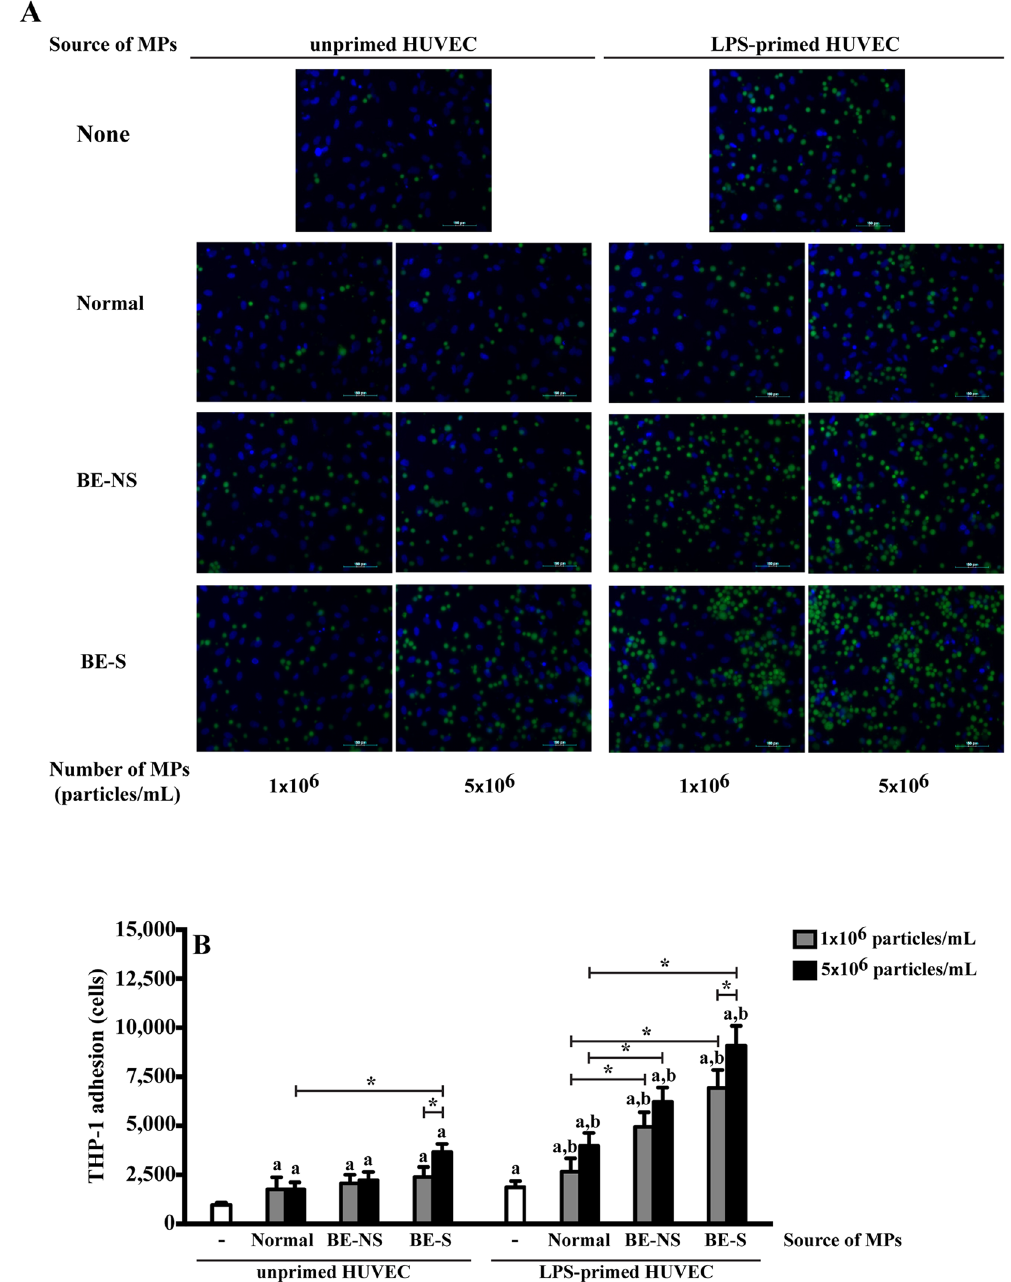
Figure 5. MPs stimulate monocyte-endothelial cell adhesion. Unprimed and LPS-primed HUVECs were treated with 1 × 10 6 and 5 × 10 6 particles/mL MPs obtained from 7 normal subjects, 9 non-splenectomised β -thalassaemia/HbE patients (BE-NS) and 9 splenectomised β -thalassaemia/HbE patients (BE-S). HUVECs were stained with Hoechst (blue), and BCECF-AM-labeled THP-1 cell lines (green). ( A ) The illustration was captured fluorograph at × 200 magnification by fluorescent microscopy. ( B ) The fluorescent intensity of the amount of adhered THP-1 cells was detected by fluorescent plate reader and calculated by normalised with untreated HUVECs. a Statistically significant difference when compared with unprimed HUVECs at P < 0.05. b Statistically significant difference when compared with LPS-primed HUVECs at P < 0.05. * Statistically significant difference between groups at P < 0.05. Each experiment was